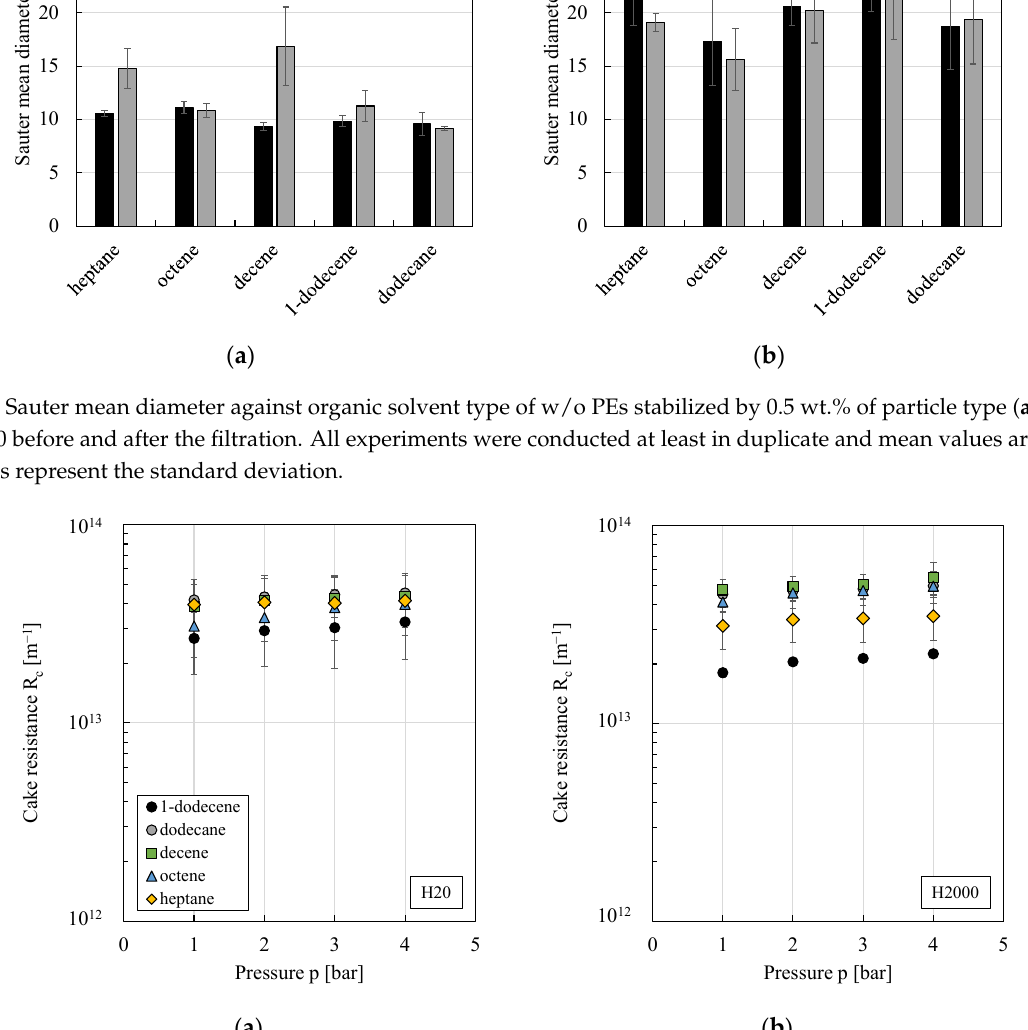
( b ) Figure 11. Calculated flux vs. experimental flux for w/o PEs prepared using different organic solvents and stabilized by particle type ( a ) H20 or ( b ) H2000. For the model fit (solution–diffusion model combined with a resistance in series model,